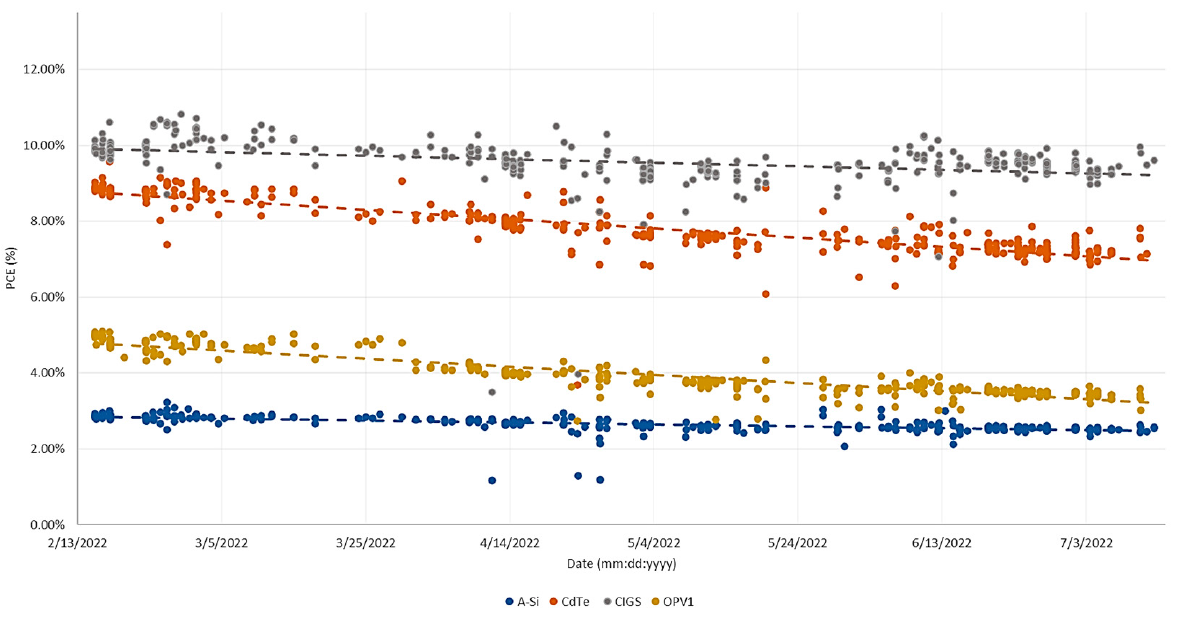
Figure 11. Variation of PCE in PVMS2 during four months at Irr = 1000 ± 5 (W/m 2 ), average Tamb = 27.53 °C, average humidity = 66.86%.